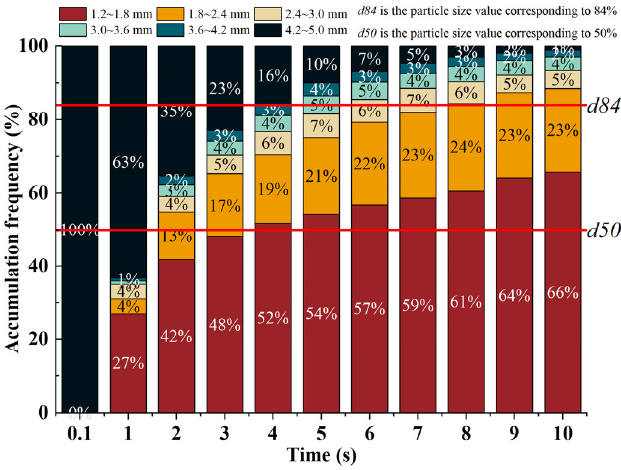
Figure 12. The particle size changes distribution across the duration of the granulation process.